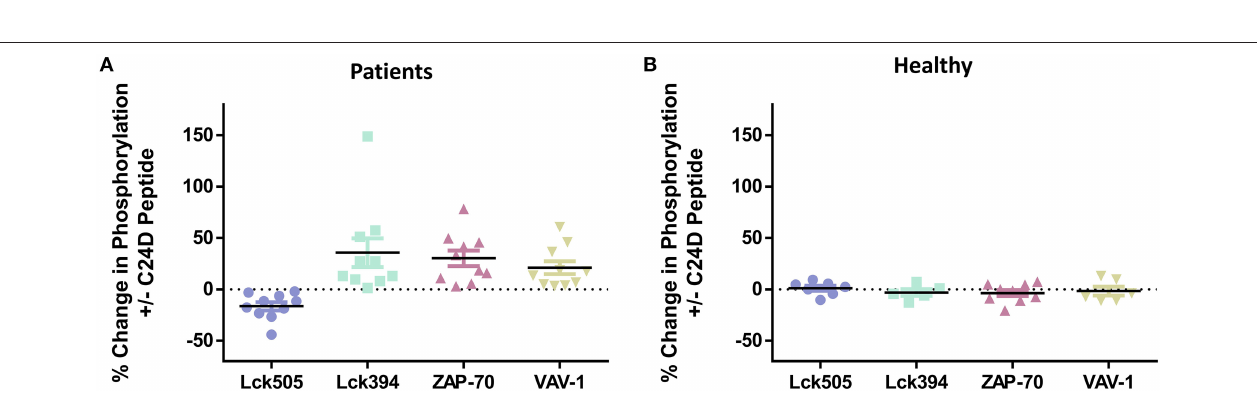
FIGURE 2 | C24D reversed CD45 immune suppression signaling only in patients: (A) Percentage change of Lck, ZAP-70 and VAV-1 phosphorylation in PBMCs from each of the 10 patients, after addition of C24D for 5–60min, normalized to control without C24D. (B) Percentage change of Lck, ZAP-70 and VAV-1 phosphorylation in PBMCs from healthy donors, after addition of C24D for at least 24h, normalized to control without C24D.